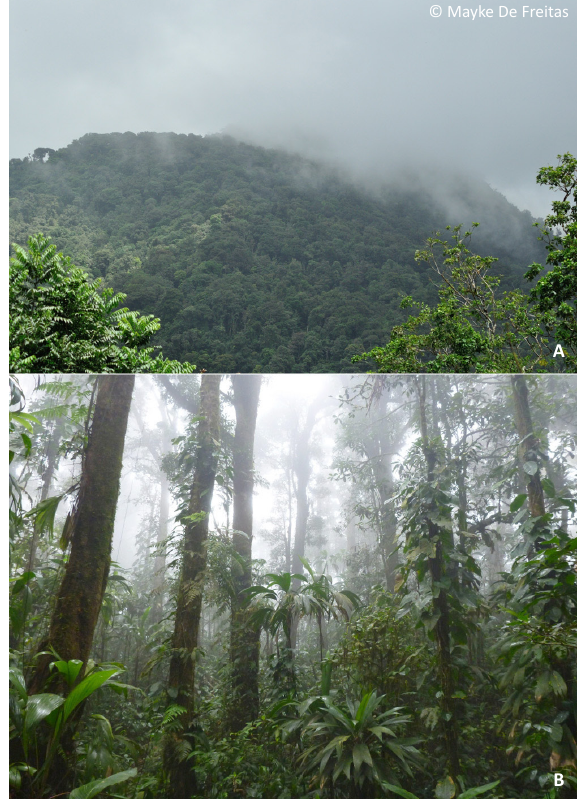
Image 2. Photographs of Cerro Humo in the Península de Paria, provided as an example for the cloud forest habitat in which the five new species of Pristimantis were discovered. (A) A rare view of the nearly unobstructed peak of Cerro Humo taken from the village of Las Melenas. (B) Dense cloud forest habitat on the southern versant of Cerro Humo, near the type locality for the five new species of Pristimantis